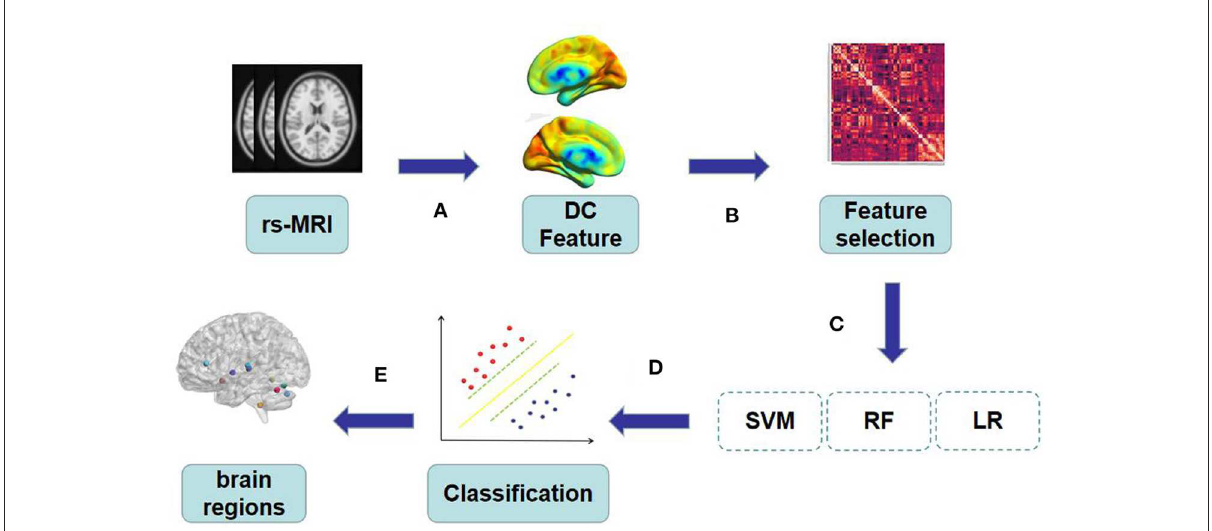
FIGURE1 (A) The original rs-MRI was preprocessed and regions of interest were extracted by AAL template as features. (B–C) All the features extracted from DC were screened for feature correlation, and the minimum absolute contraction and Selection operator logic method was used for 10-fold cross verification to retain the features with non-zero coefficients. (D) The extracted features are trained by SVM, RF and LR to obtain the best model. (E) Visual mapping of brain regions according to the characteristics of the best model.